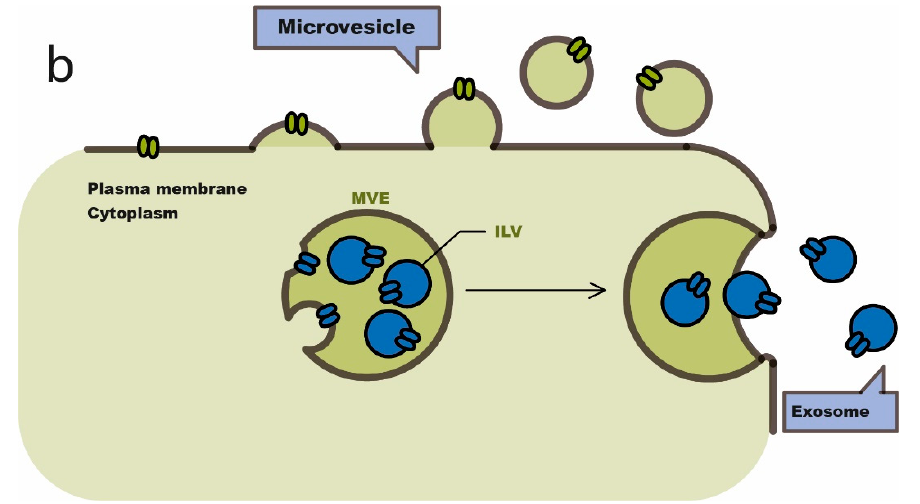
Figure 1. Scheme of the biogenesis of exosomes and microvesicles. Modified from Van Niel, 2018 (Concession Nature Review) [60]. ILV: intraluminal vesicle; MVE: multivesicular endosomes.